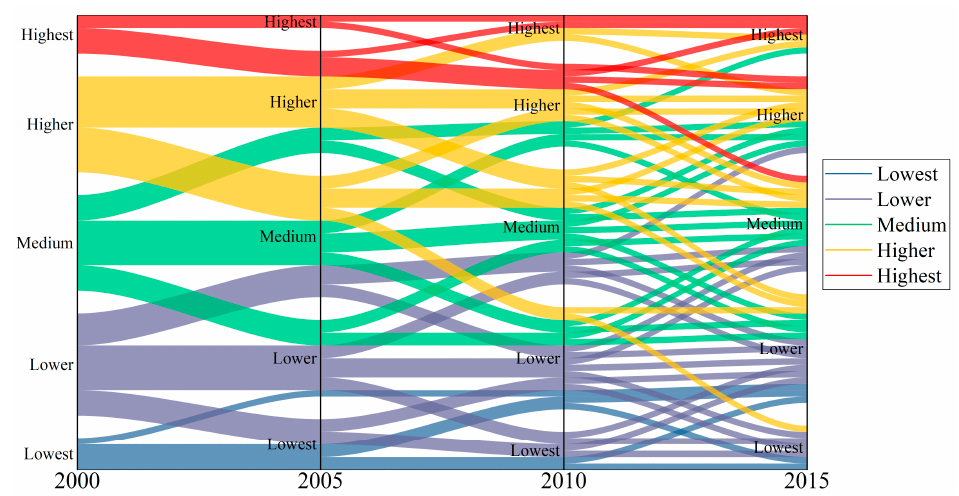
Figure 11. Sankey diagram of LER level change in Ningxia from 2000 to 2015.